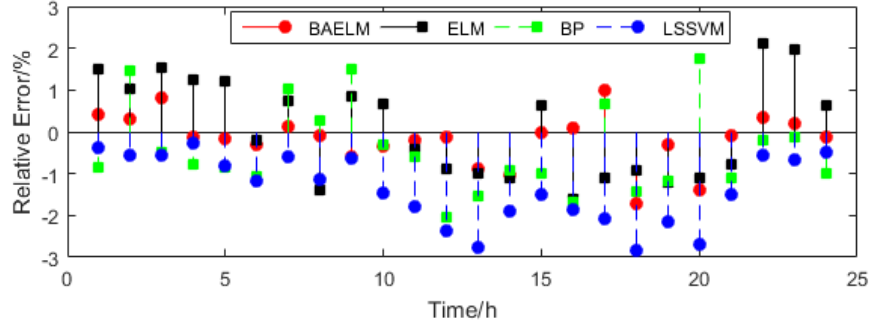
Figure 11. Compared relative errors of four models on 28 June.